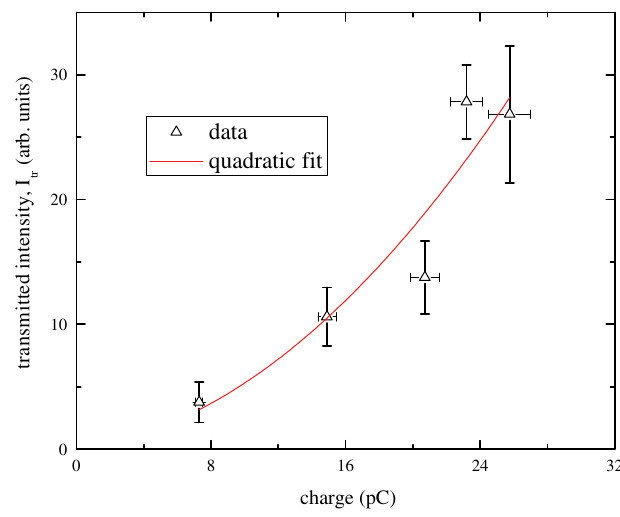
FIG. 8. (Color) EOS transmitted intensity as a function of elec- tron bunch charge. The minimum charge for which an EOS signal was measured here is 7.3 pC. A quadratic fit is used to guide the eye.